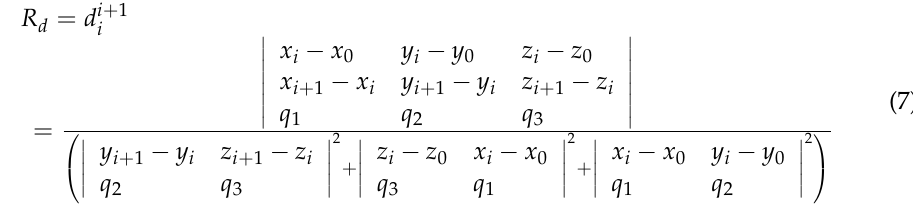
Table 1. The radius of spiral climbing gaits by